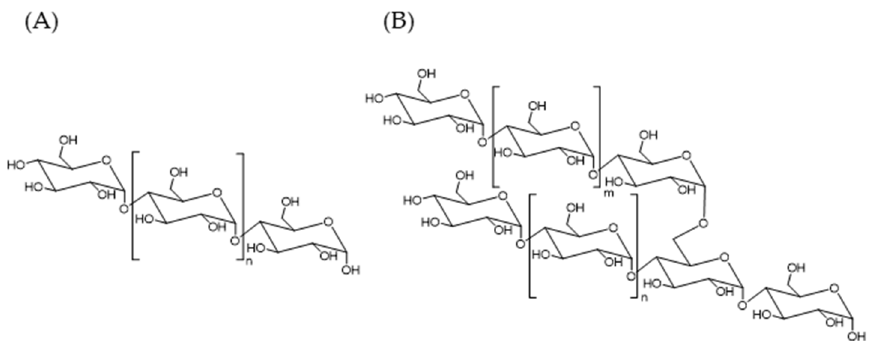
Figure 1. Chemical structure of ( A ) amylose and ( B ) amylopectin.